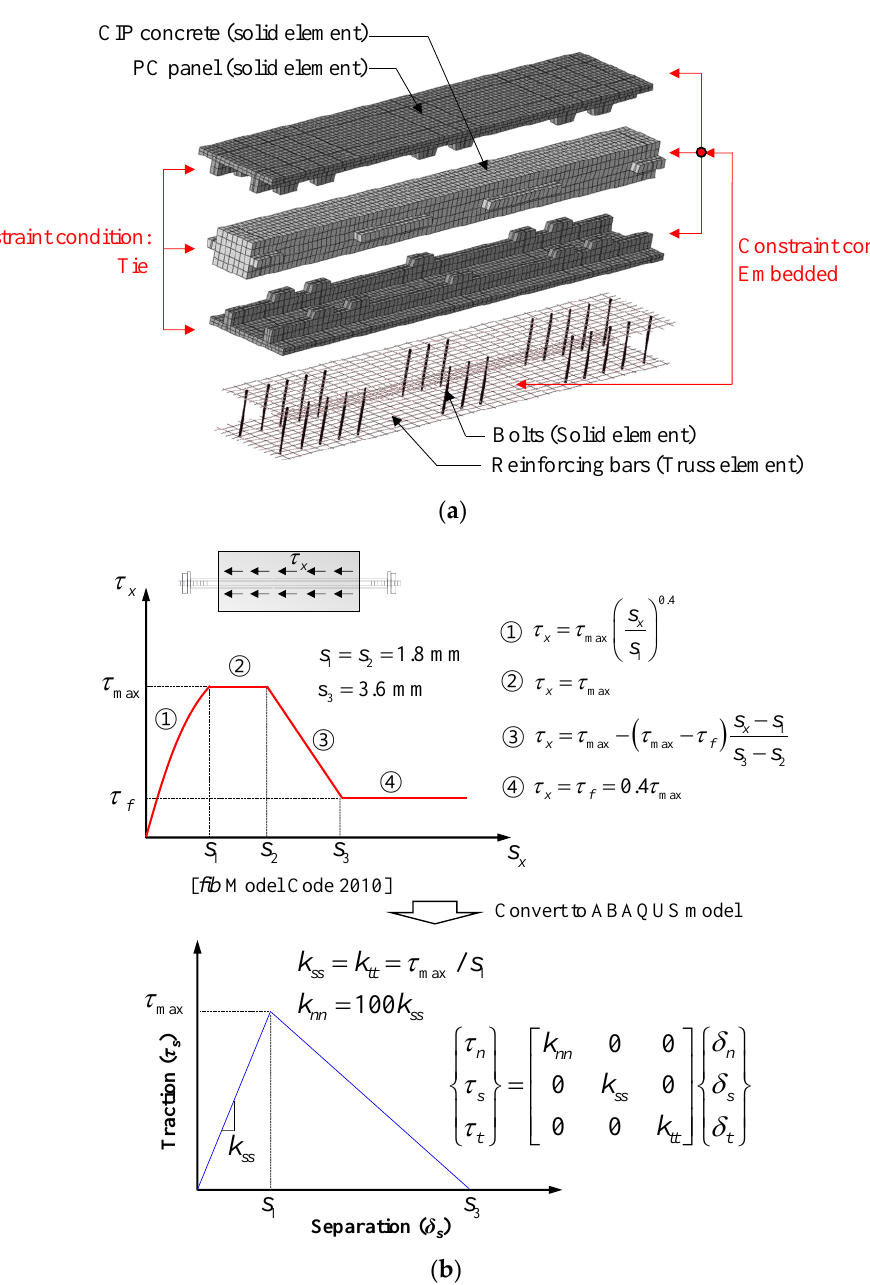
Figure 10. Finite element model for shear analysis: ( a ) schematic description of the finite element model; ( b ) bond–slip relationship between bolts and concrete.